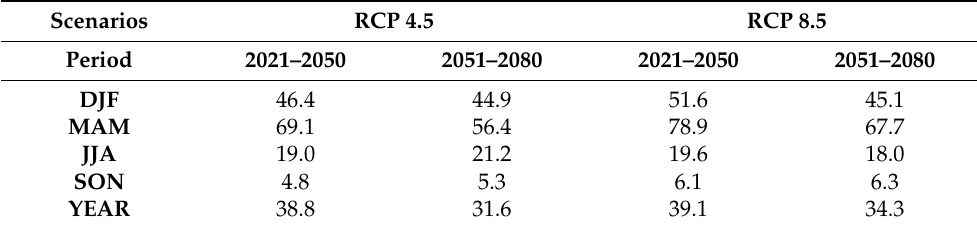
Table 4. Projections of generation potential (%) relative to the maximum installed capacity.